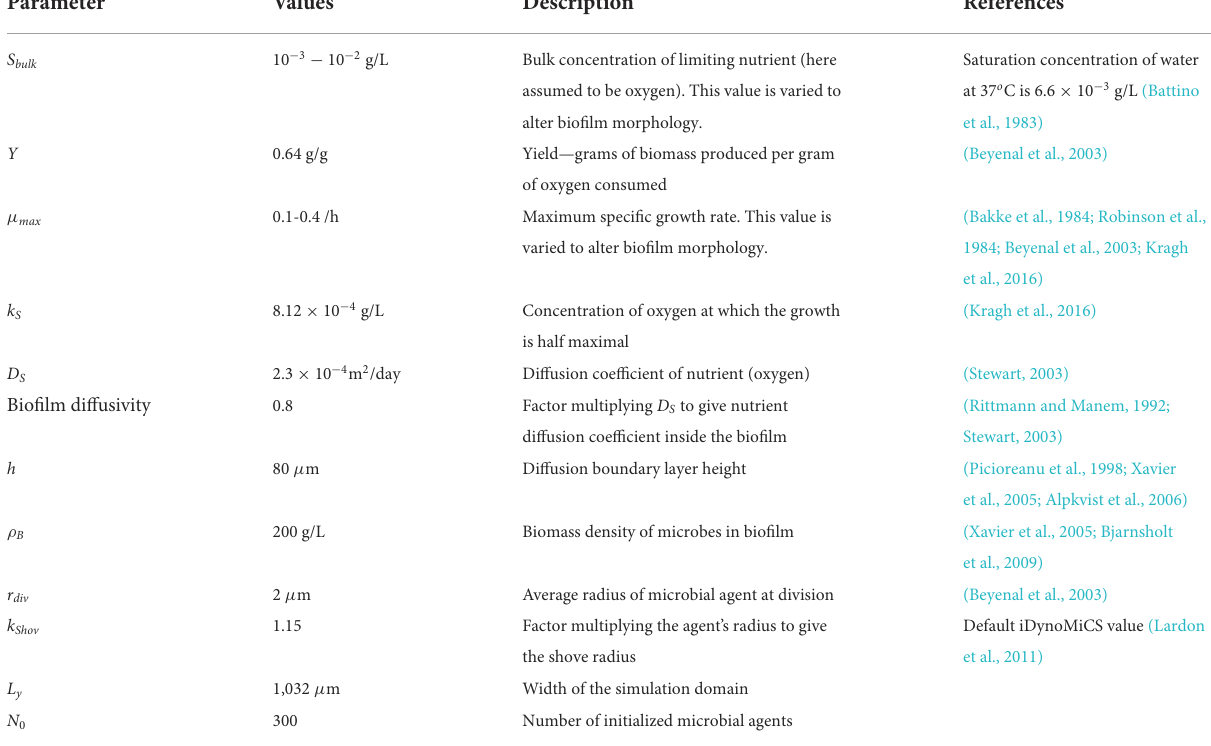
TABLE 1 Input values used in our iDynoMiCS biofilm